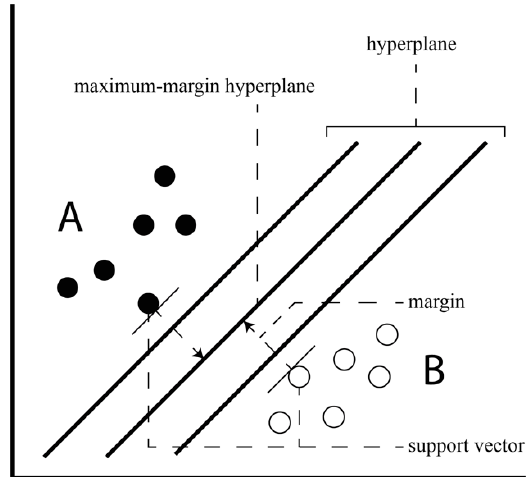
F igure 4. Hyperplane and margin of SVM. Figure 4. Hyperplane and margin of SVM.